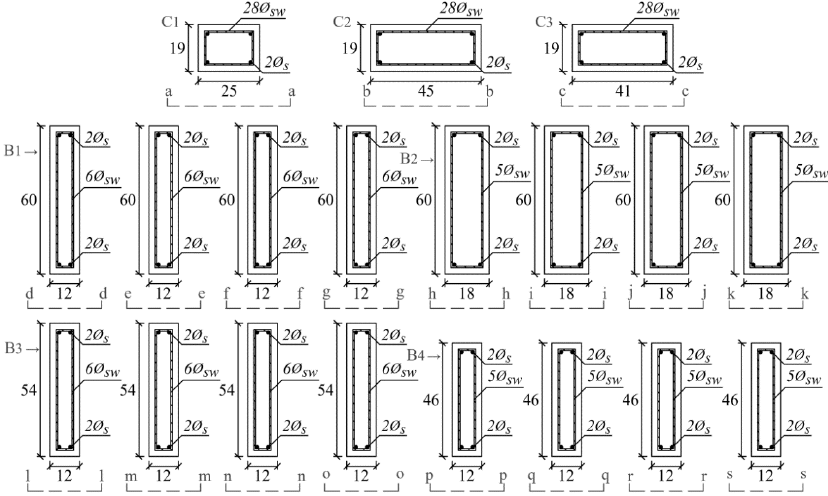
Figure 14. Detailing the optimal sections (dimensions in cm) - Example II: case